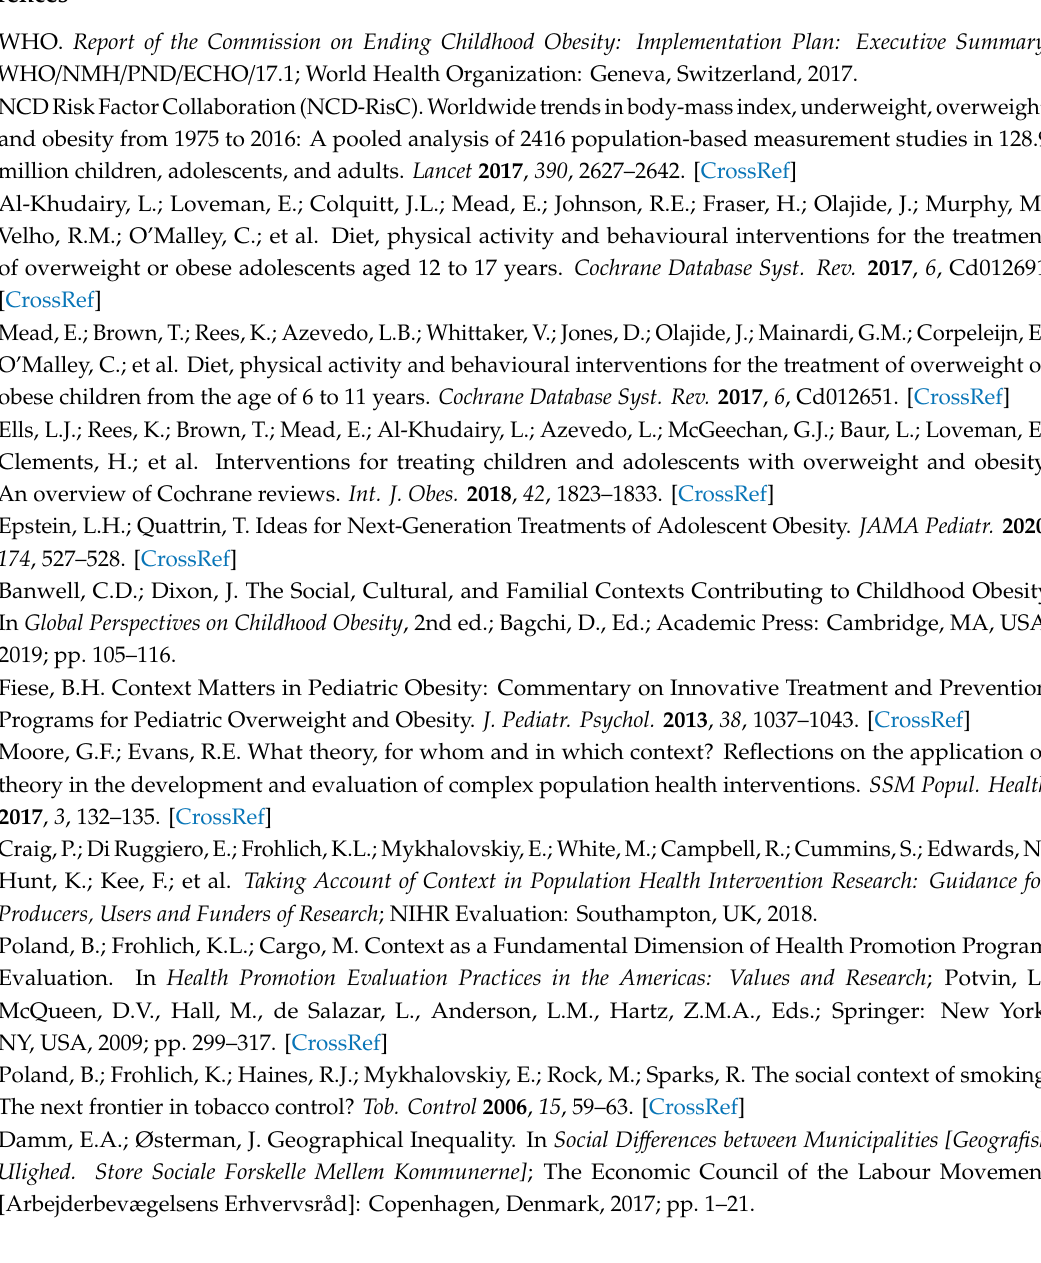
Table S1: Overview of the coding process and the second order